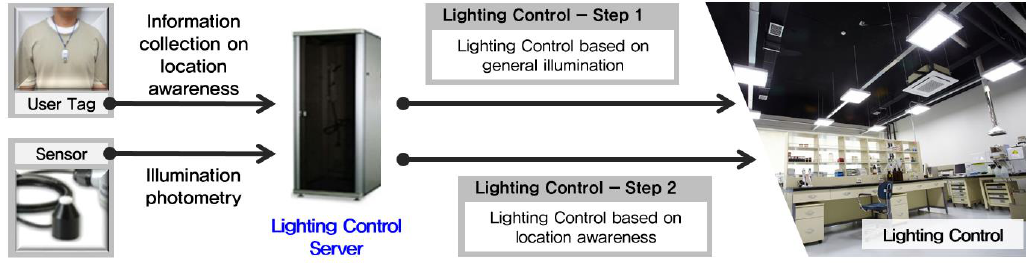
Figure 1. The concept of the lighting control system applying general illumination and location- awareness